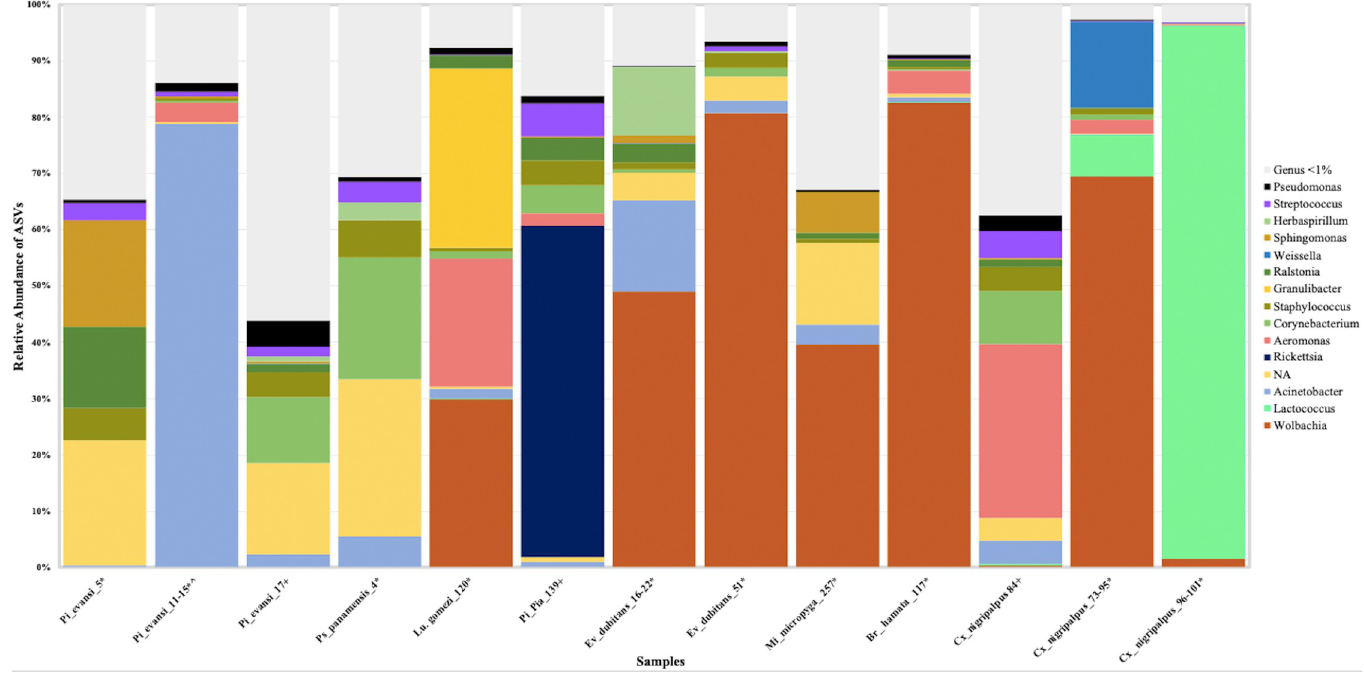
Fig 6. Microbiota composition and diversity of wild specimens of sand flies and Culex nigripalpus found with endosymbiont in several regions or departments from Colombia. A) Relative abundance of ASVs that were called to the taxonomic rank of genus. The ASVs with abundances above 1% of the rarefied count matrix were selected. See Table 4 for the nomenclature of samples in detail. NA: ASVs without taxonomic